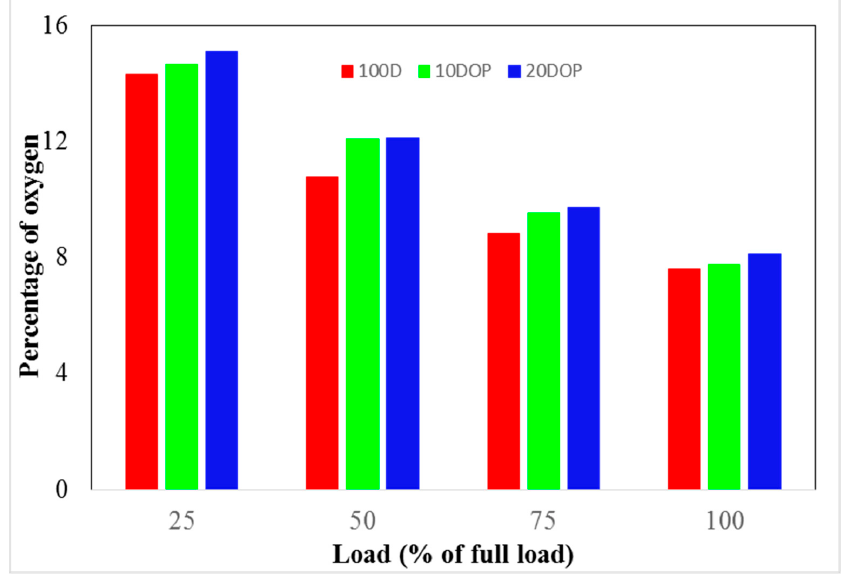
Figure 12. Percentage of oxygen contained in the exhaust gas for diesel and DOP blends.